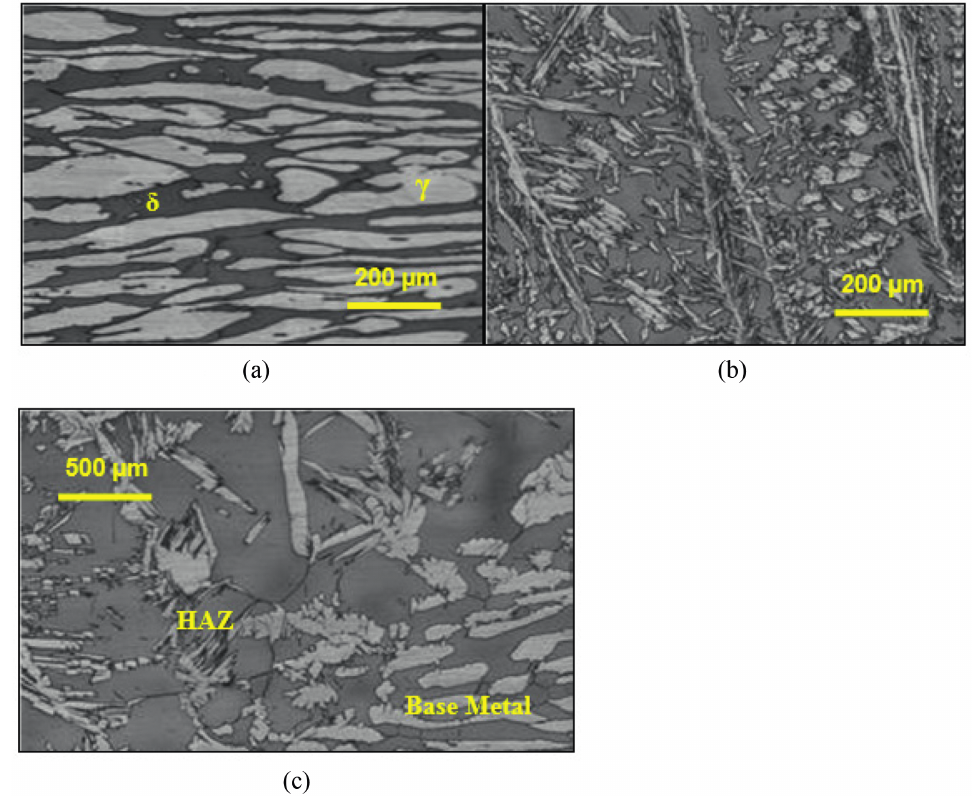
Figure 9: Microstructure of the (a) base metal: austenite is white and ferrite is dark (b) weld metal and (c) HAZ + base metal.